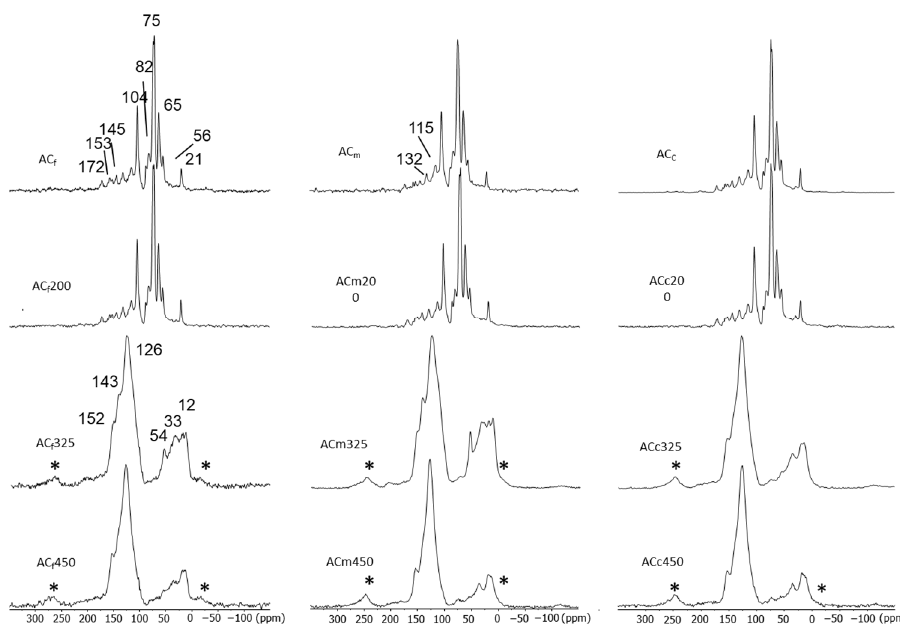
Figure 3. Solid-state 13 C NMR spectra of the uncharred endocarp of Acrocomia (AC) at different particle sizes (f: fine; m: middle; c: coarse) and its biochars produced at 200 ◦ C (AC200), 325 ◦ C (AC325) and 450 ◦ C (AC450). Asterisks indicate spinning side bands.